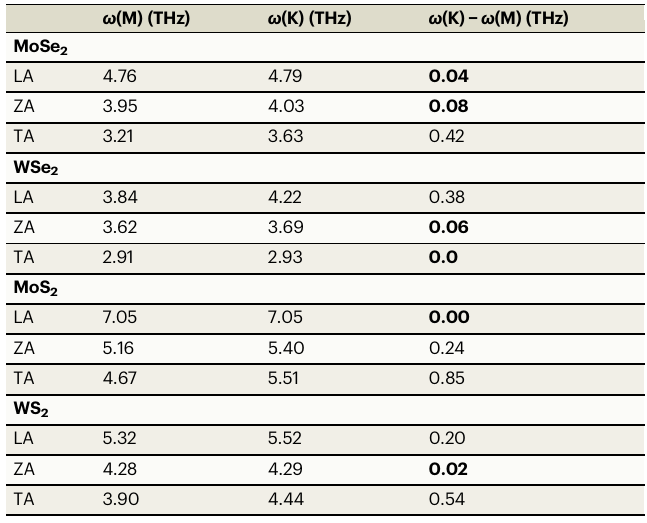
Table 1 | Phonon frequencies of acoustic branches (LA, ZA, and TA) at the M and K points in several transition